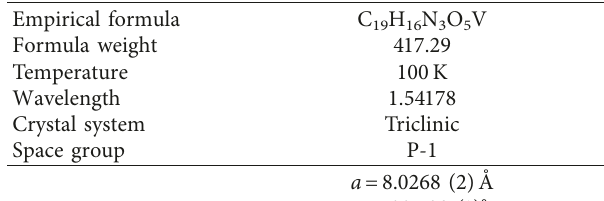
Table 1: Crystal data of complex 2